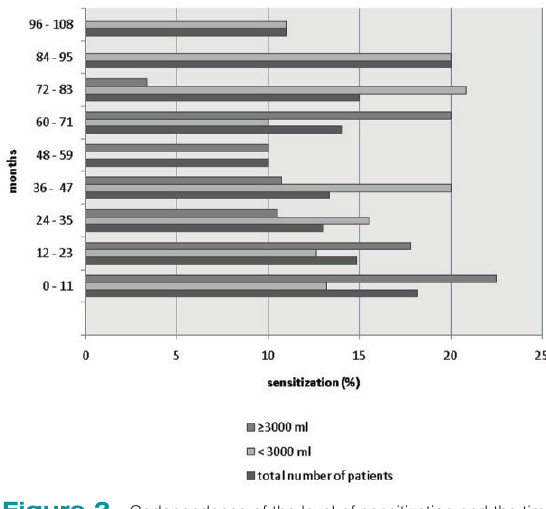
Figure 2. Codependence of the level of sensitization and the time elapsed from the last received transfusion taking into consideration volume of received units. < 3000 mL - patients who received less than 3000 mL of blood products ≥ 3000 mL - patients who received 3000 mL and more of blood products. Months - months elapsed from the last transfused blood product until the moment of testing. Sensitization (%) - average level of sensitization expressed in